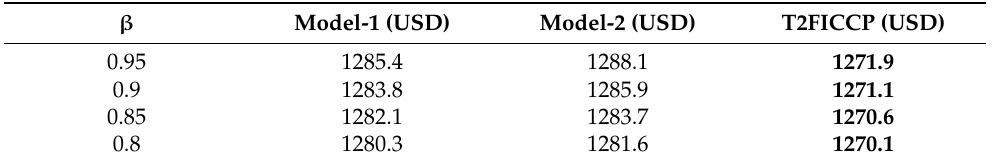
Table 2. Schedule costs for a typical day of SCday-4 at different confidence levels (PV power as well as load prediction errors are constant).